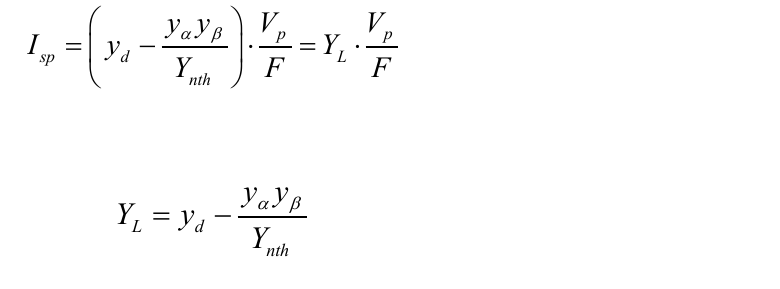
Figure 3. Two-port network model of a three-phase SEIG with unbalanced